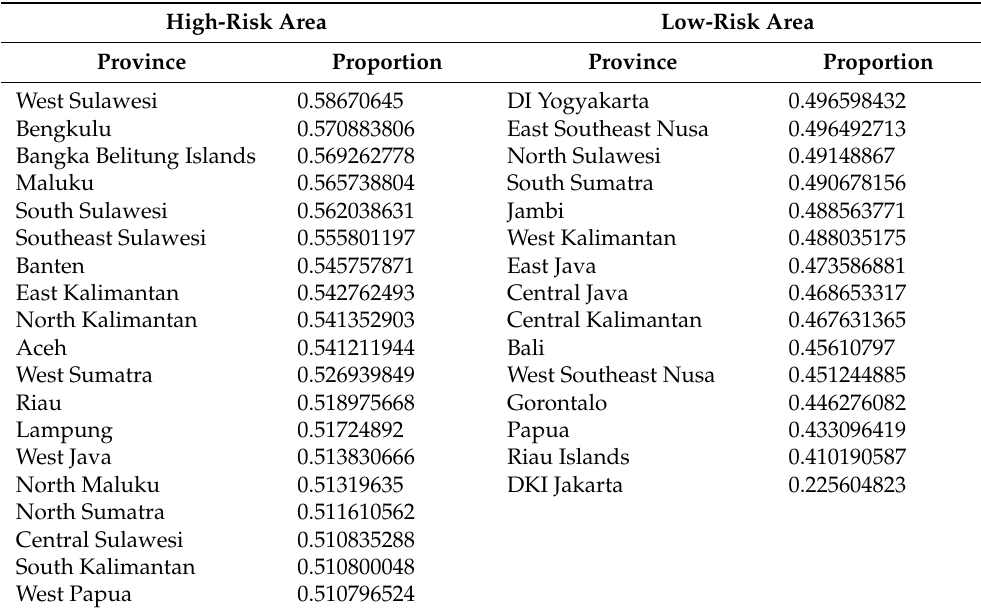
Table 1. Proportion of disaster risk index in each province in Indonesia.